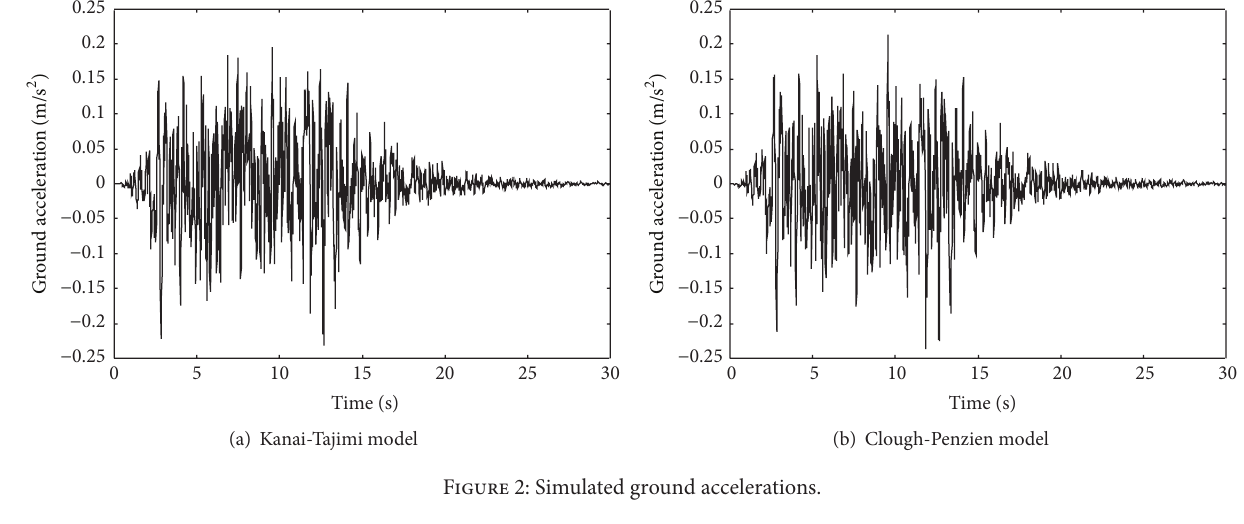
Figure 2: Simulated ground